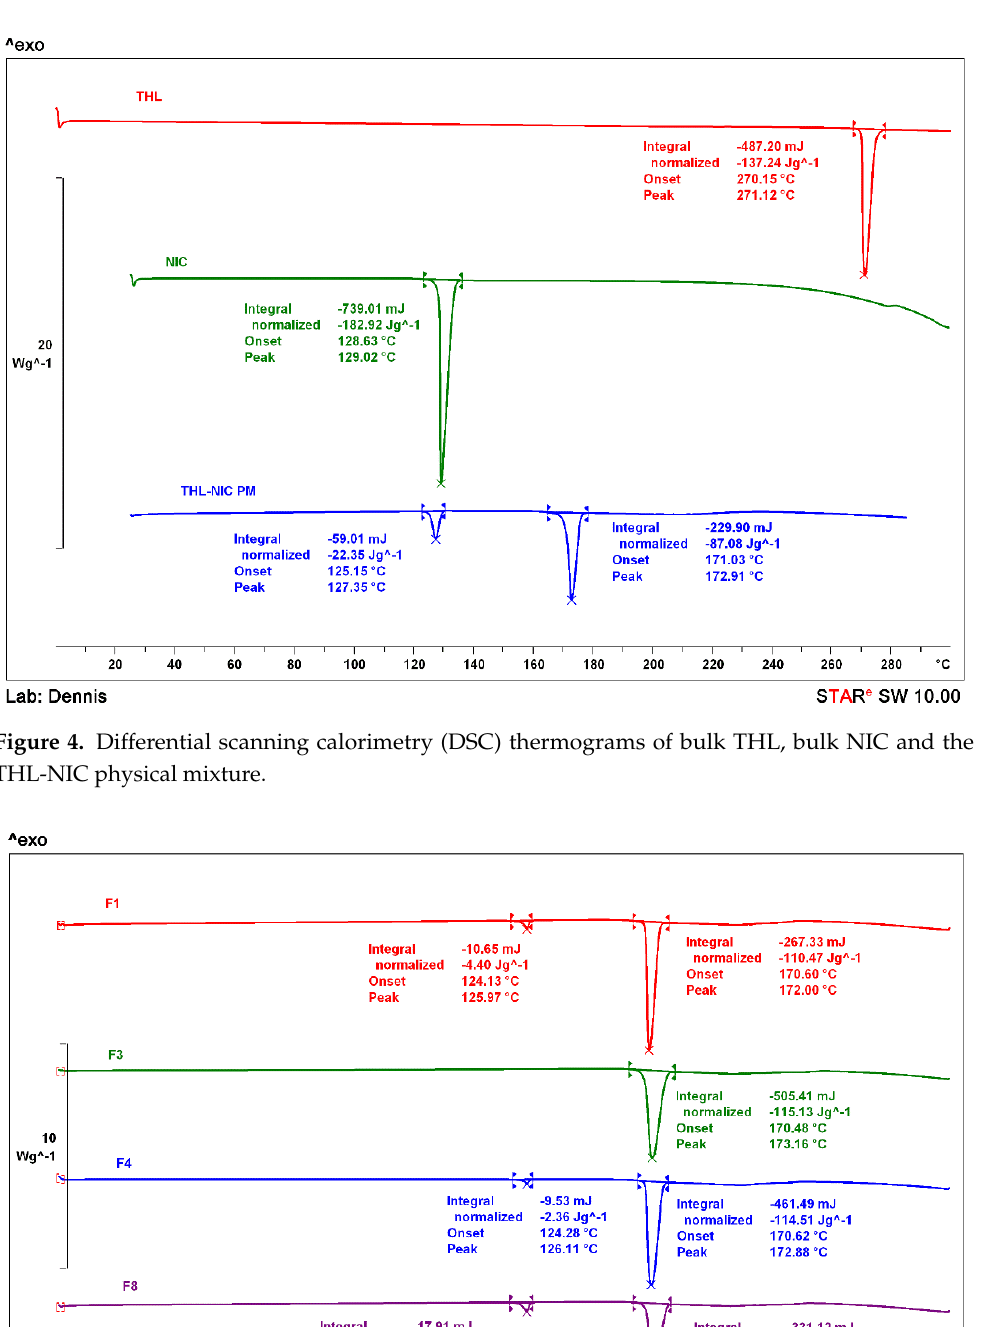
Figure 5. DSC thermogram of THL-NIC extrudates processed at various extrusion settings.